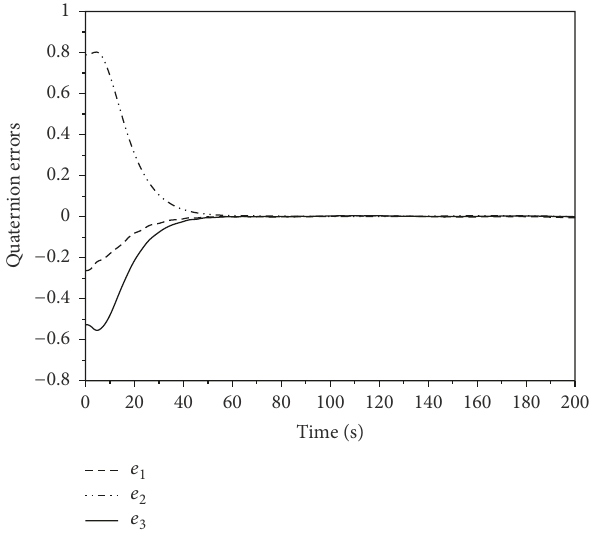
Figure 1: Quaternion errors under PD-SMC.